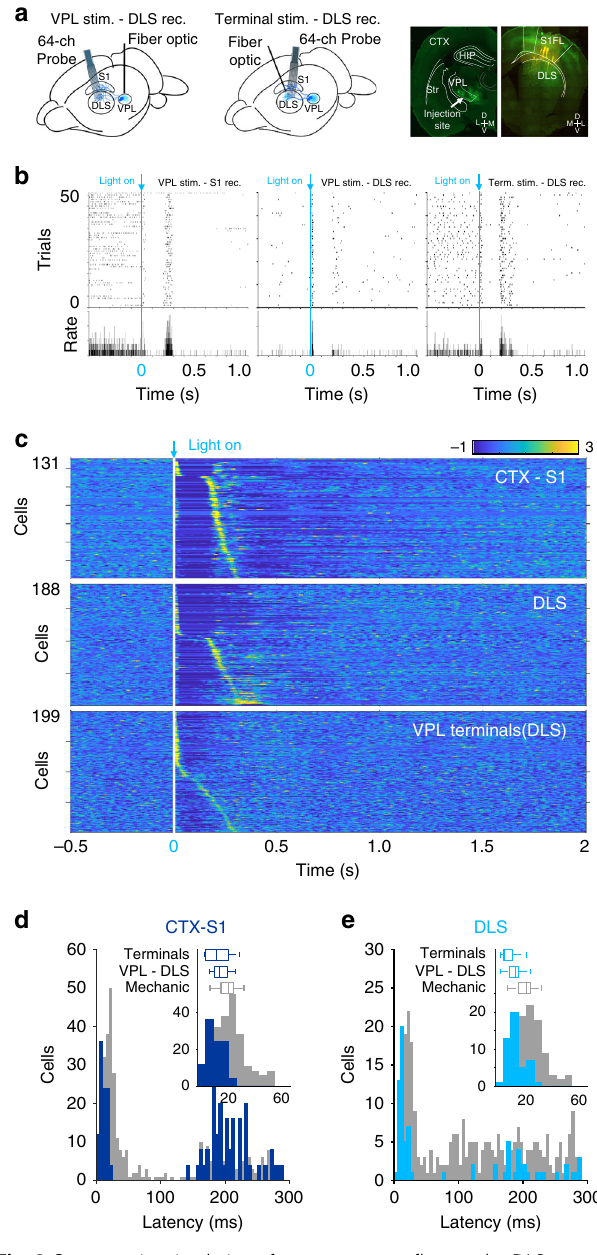
Fig. 2 Optogenetic stimulation of somatosensory fl ow to the DLS. a Schematic representation of experimental con fi guration and anatomical con fi rmation of infections. b Spike rasters (top) and average peri-event histograms (bottom) of three illustrative units aligned to the onset of optical stimulation of the VPL and recordings in S1(left) or DLS (middle), and simultaneous stimulation and recording in the DLS (right). c Averaged fi ring rates for cells recorded in S1 (top) and DLS (middle) after stimulation of the VPL or its terminals in the DLS (bottom), expressed as Z -score (color coded) and sorted according to the time they reached the highest activity after stimulus onset. Histograms of the response latencies for all cells recorded in S1 ( d ) and DLS ( e ); insets display latencies shorter than 60 ms. For comparison, the distribution of latencies evoked by somatic stimulation is presented in light gray. Box plots indicate median and 25th and 75th percentiles of the latencies evoked by somatic stimulation or stimulation of the VPL or its terminals in S1 ( d ) or DLS ( e